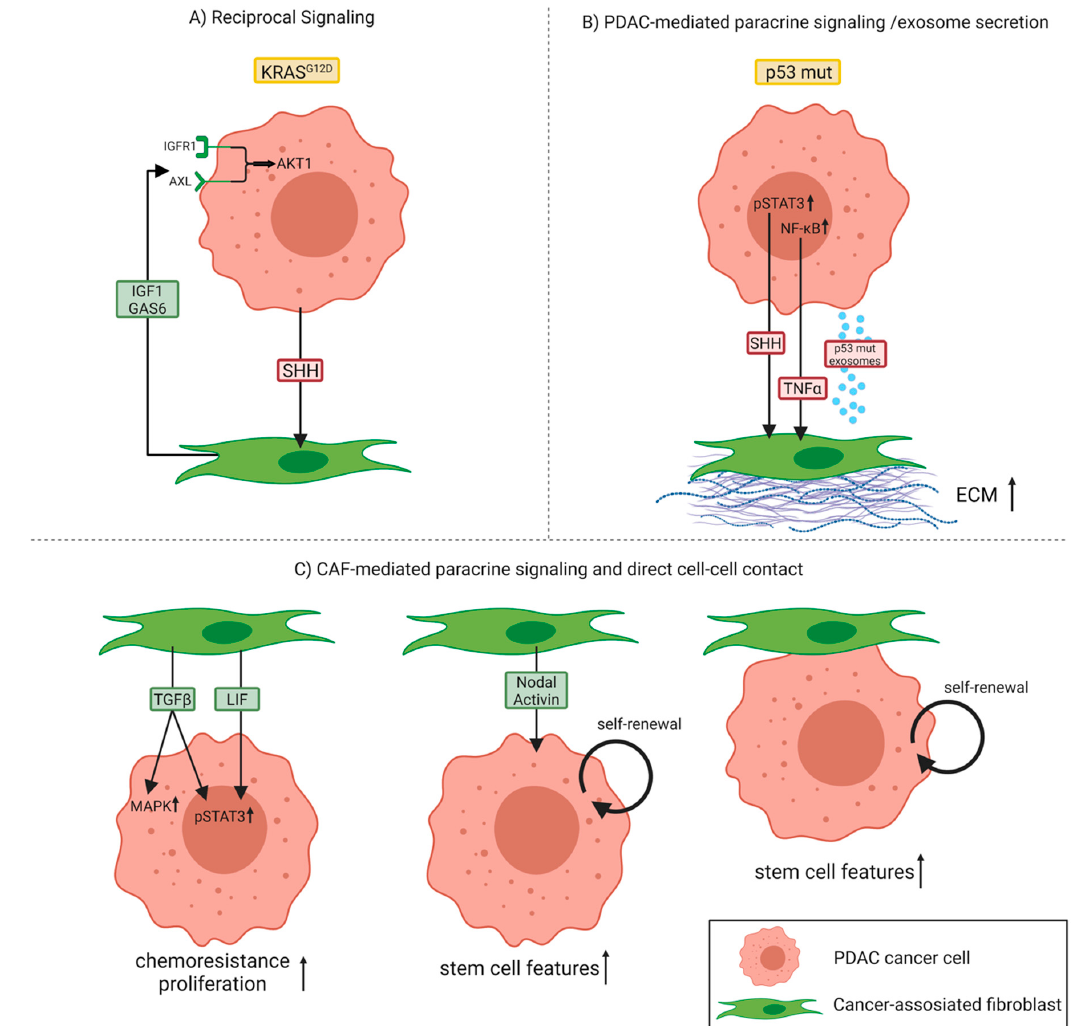
Figure 2. Different mechanisms of crosstalk between pancreatic ductal adenocarcinoma (PDAC) cancer cells and cancer-associated fibroblasts (CAFs). ( A ) Communication between PDAC cancer cells harboring mutant KRAS G12D and CAFs can occur via a reciprocal signaling network. ( B ) PDAC cancer cells with mutant p53 (p53 mut), which exhibit persistent activation of signal transducer and activator of transcription 3 (STAT3) and enhanced activity of the nuclear factor- κ B (NF- κ B) signaling pathway, influence CAFs in a paracrine manner or through exosome secretion, stimulating the deposition of extracellular matrix (ECM). ( C ) CAFs can also secrete paracrine factors acting on cancer cells that lead to an upregulation of mitogen-activated protein kinase (MAPK) and STAT3 signaling and finally to PDAC progression and chemoresistance. Both CAF-secreted factors and direct PDAC–CAF interactions can further induce PDAC stem cell features, thereby promoting self-renewal capacity and invasiveness. Abbreviations: sonic hedgehog (SHH); insulin-like growth factor 1 (IGF1); insulin-like growth factor 1 receptor (IGFR1); growth arrest-specific gene 6 (GAS6); tumor necrosis factor-alpha (TNF- α ); transforming growth factor-beta (TGF- β ); leukemia inhibitory factor (LIF).